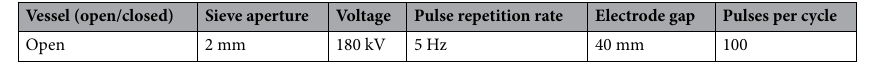
Table 1. Treatment conditions for electric pulse